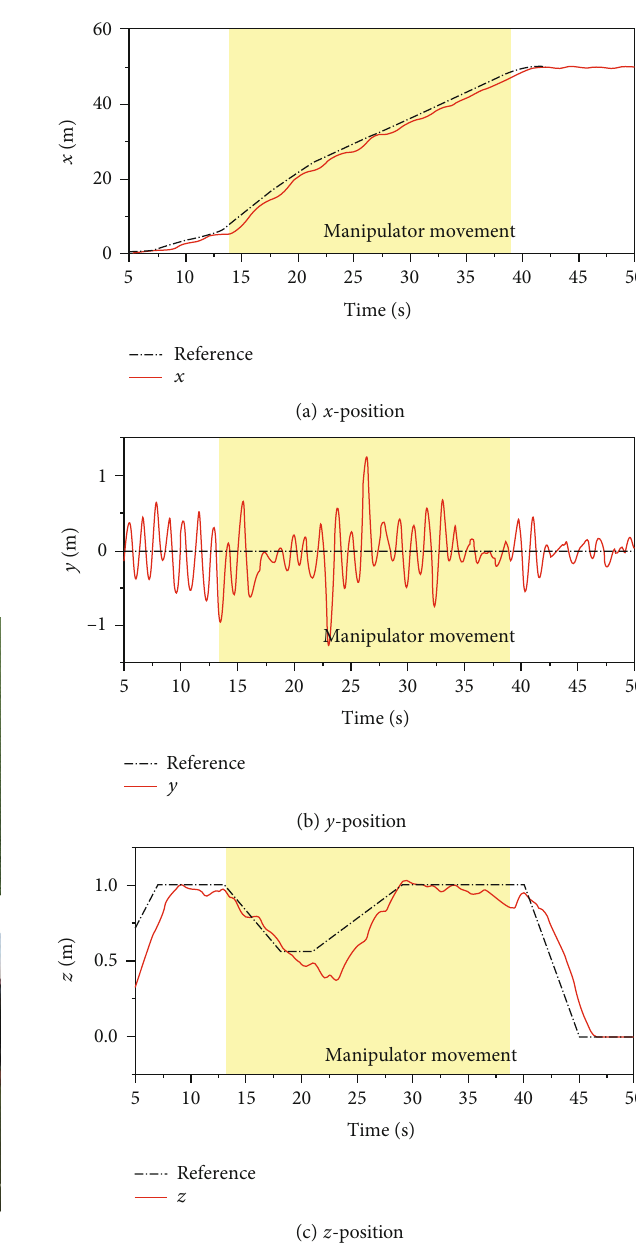
Figure 13: Position trajectories in time